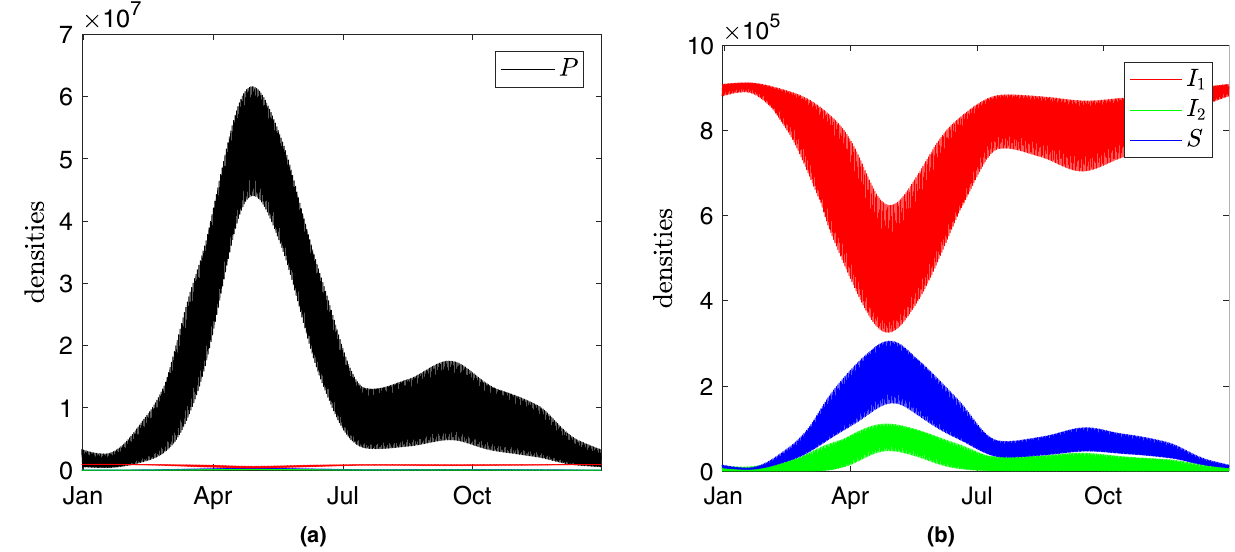
Figure 4. ( a , b ) Daily and seasonal temporal dynamics of bacteria and phage numbers within the upper 20 cm of the soil predicted by the model for Nakhon Phanom province in Thailand. Model parameters are taken from Table 1 as default values. The unit of the densities of bacteria and phages are cell/ml and phage/ml,